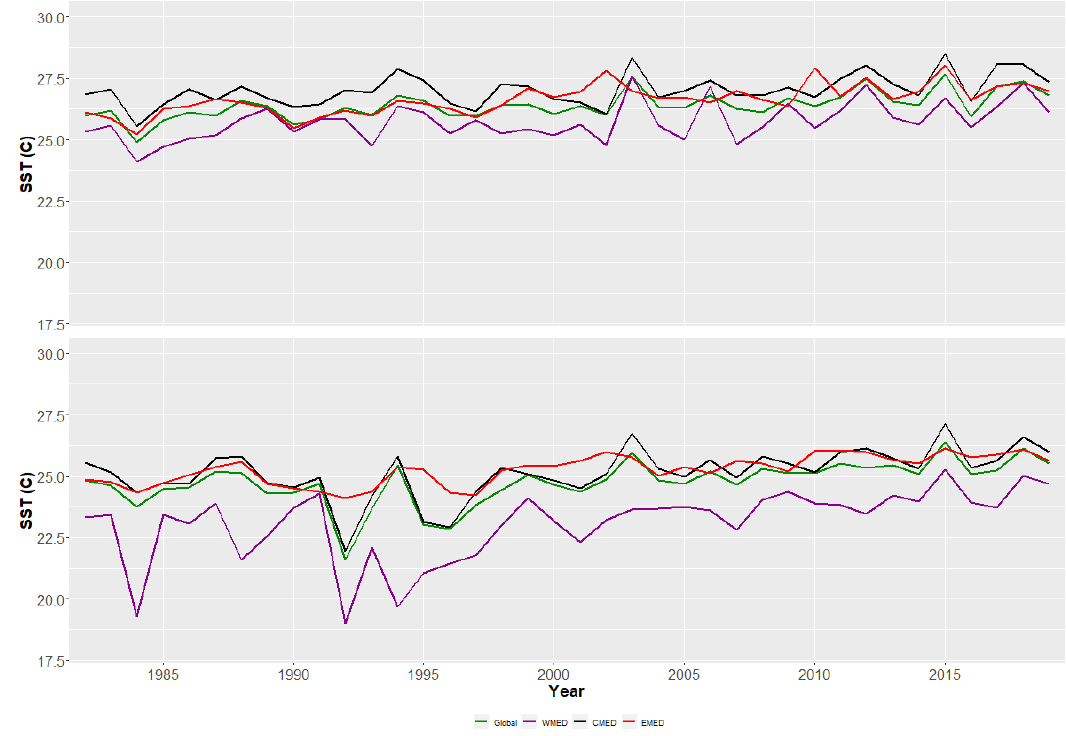
Figure 8. Yearly time series of maximum SST ( upper panel ) and SST corresponding to the maximum density ( bottom panel ) for summer (SST higher than the yearly median) in the global Mediterranean basin and WMED, CMED and EMED sub-basins.